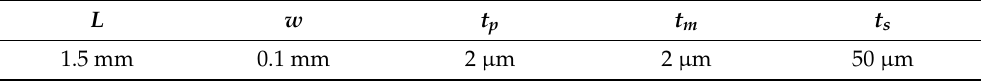
Table A1. Geometric Parameters for the Cantilever Beam with Composite Films.